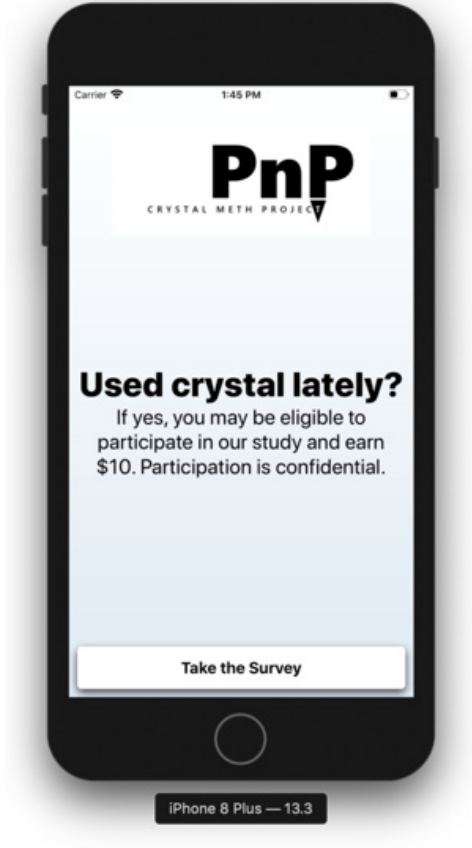
Figure 1. Example Ad used in recruitment.